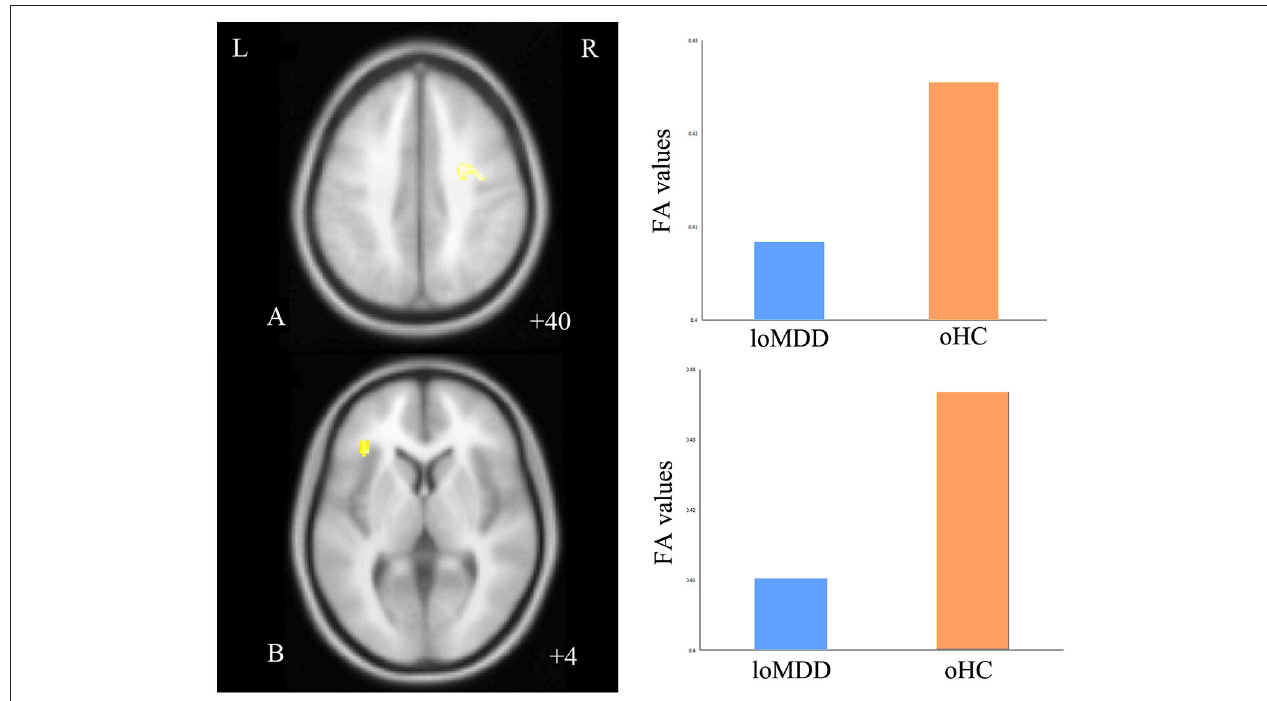
FIGURE 1 | Regions of differences for white matter integrity between medication-naïve patients with major depressive disorder (MDD: eoMDD, onset age ≤ 25 years old; loMDD, onset age > 25 years old) and healthy controls (HC: yHC, younger healthy controls; oHC, older healthy controls). (A) The axial image ( z = + 40mm) shows the significantly decreased fractional anisotropy (FA) values in the right superior longitudinal fasciculus (SLF) with loMDD, compared to oHC. (B) The axial image ( z = + 4mm) shows the significantly decreased FA values in the left inferior fronto-occipital fasciculus (IFOF) with loMDD, compared to oHC. The graph shows FA values for loMDD and